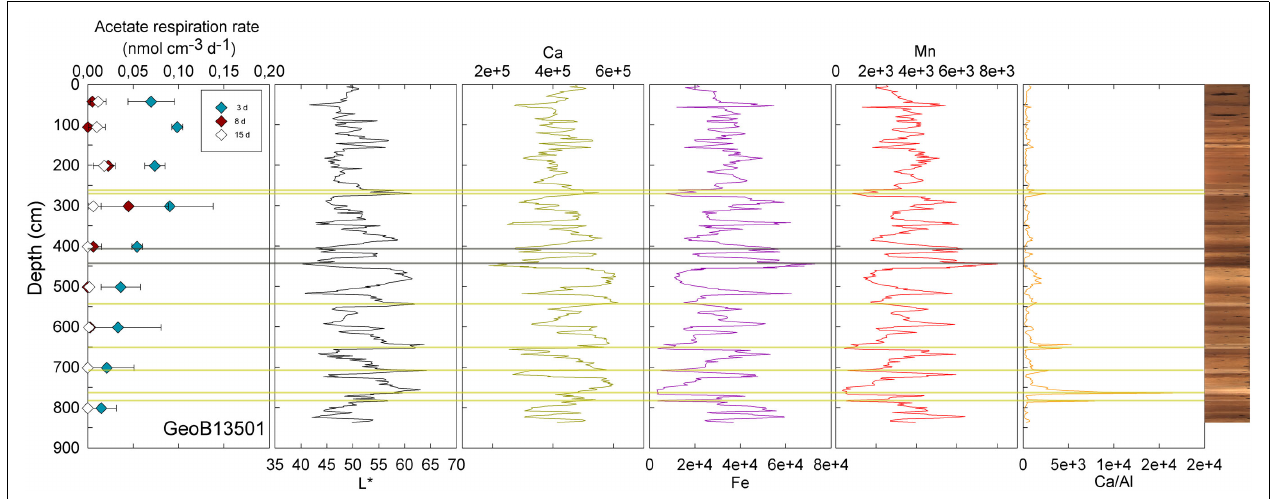
FIGURE 2 | GeoB 13501 activity rates (at 42.5, 105.5, 201.5, 301.5, 401.5, 501.5, 601.5, 701.5, 801.5cm) and detailed lithological features (L*, Ca, Fe,